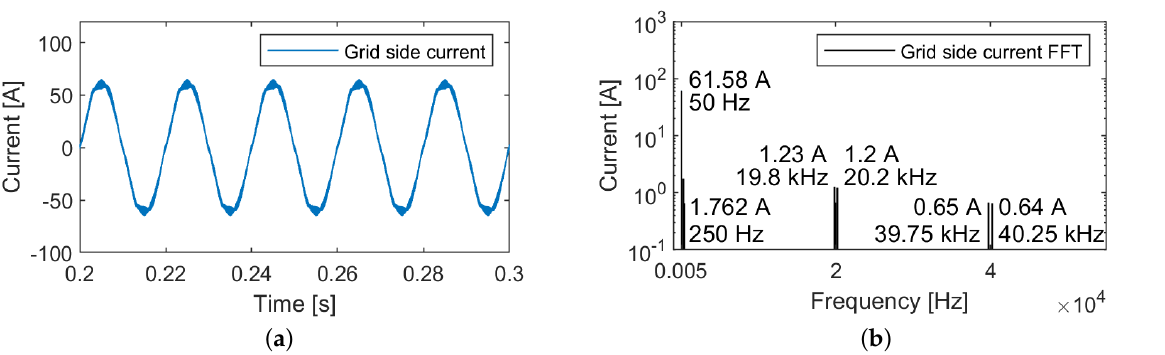
Figure 17. Three-phase three-level T-type rectifier simulation results. ( a ) Grid side current. ( b ) Grid side current harmonic analysis.